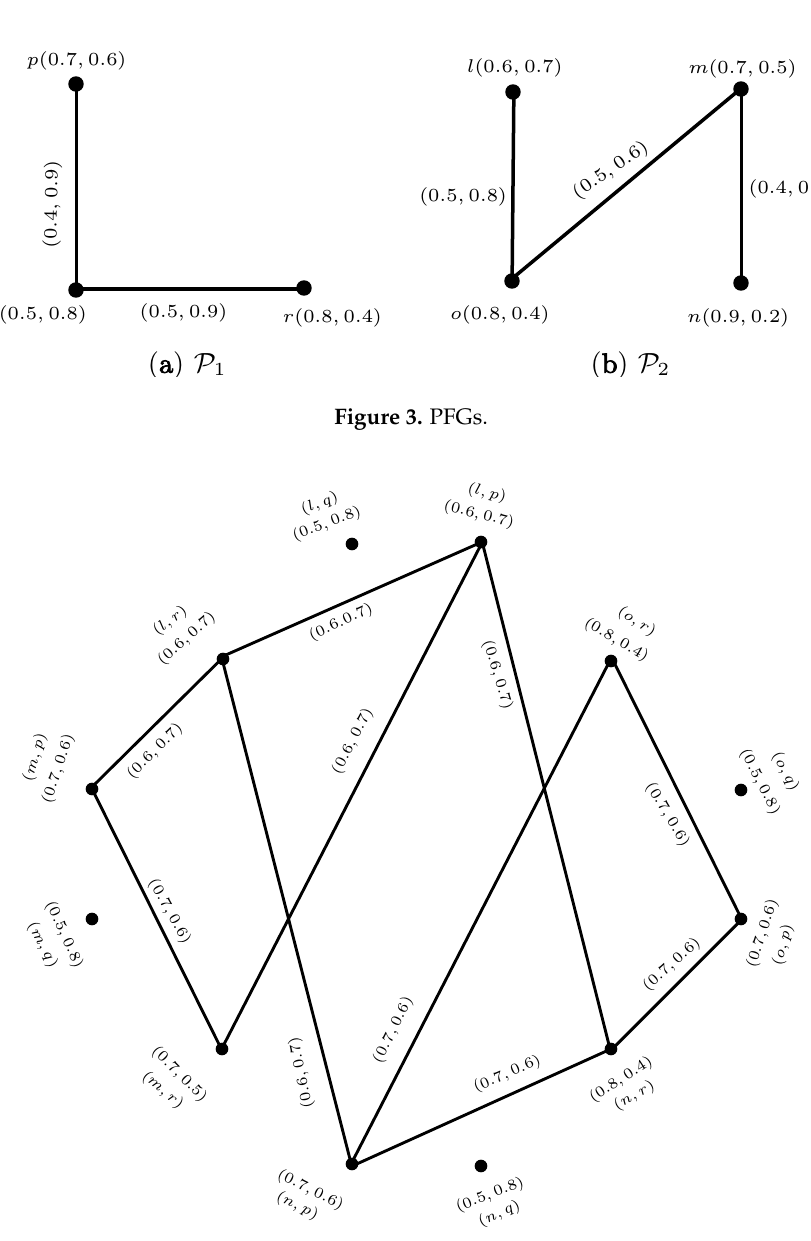
Figure 2.3: Rejection of two PFGs Figure 4. Rejection of two